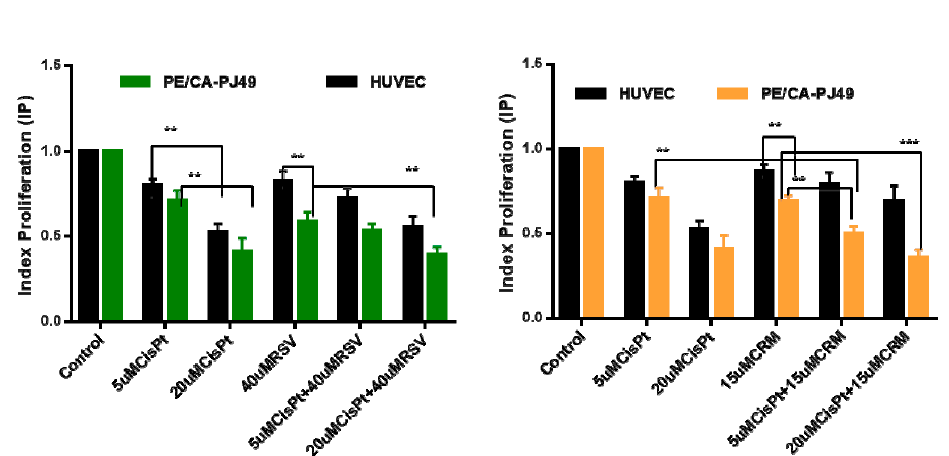
Figure 2. The index proliferation (IP) of HUVEC and PE / CA-PJ49 cells treated with CisPt and / or ( A ) RSV ( B ) CRM was calculated as IP = absorbance of treated cells / absorbance of untreated cells. Results are expressed as DO mean values of three determinations ± standard deviation (SD). Untreated cells were considered to have IP equal 1. (* p < 0.05, ** p < 0.005; *** p < 0.0005).